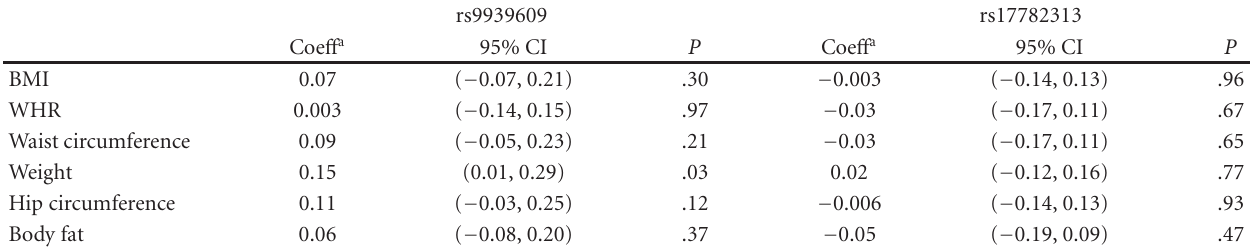
Table 3: Interactions between FTO and MC4R SNPs and rural/urban dwelling in associations with obesity traits.